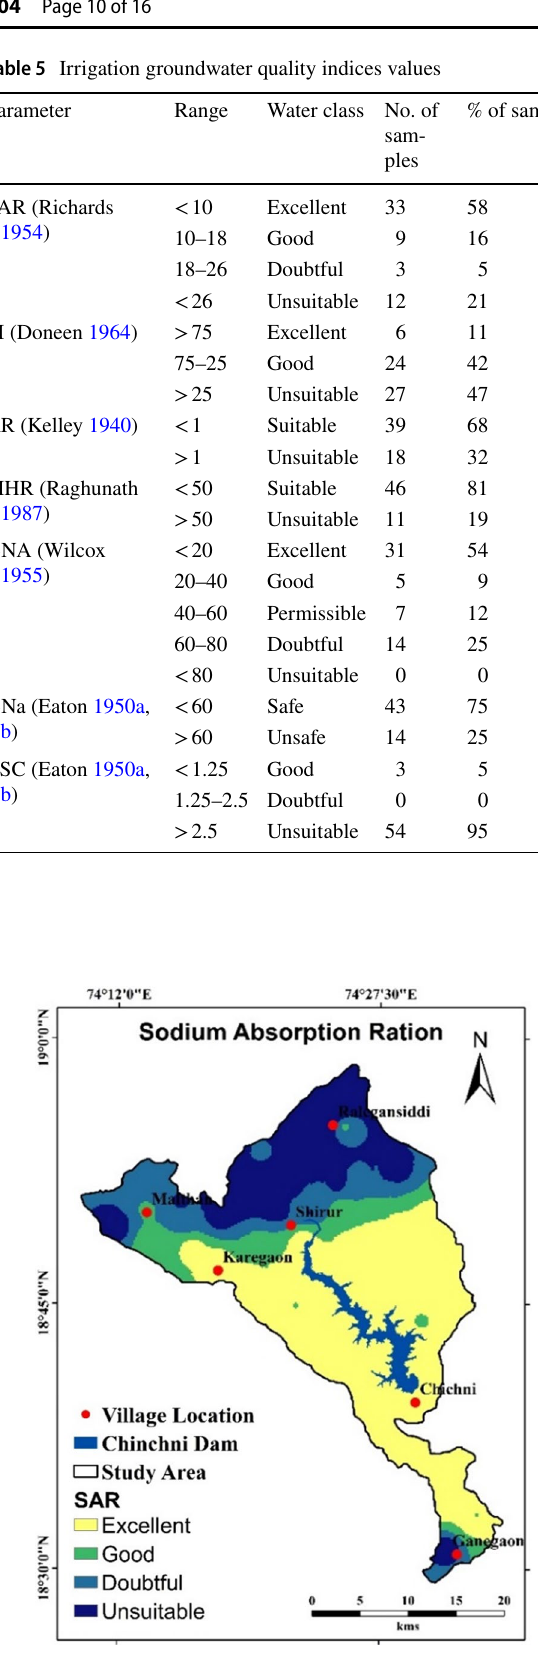
Fig. 5 Spatial variation in SAR Fig. 6 Spatial variation in